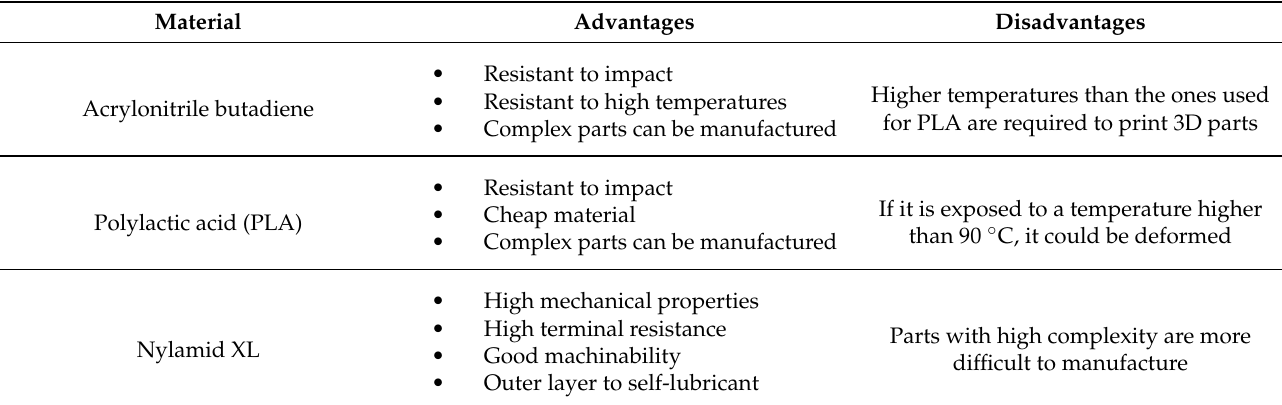
Table 1. Advantages and disadvantages of the materials proposed for the construction of the stereotactic positioning